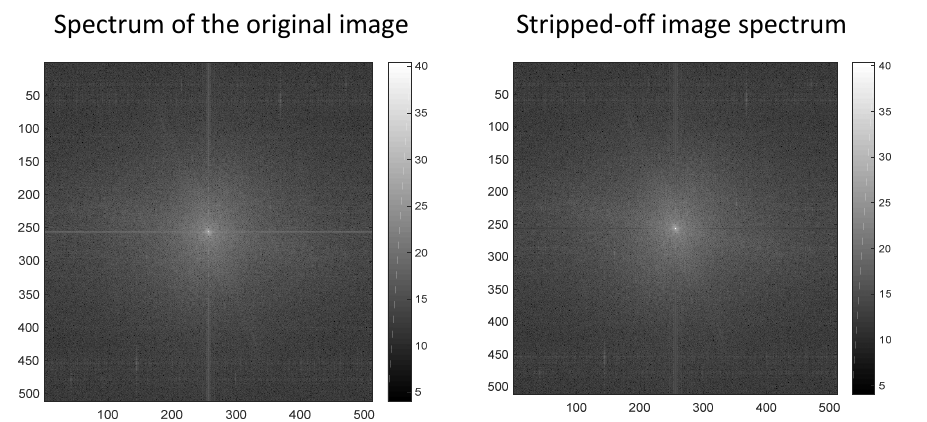
Figure 2. Spectrum of thermal infrared image from